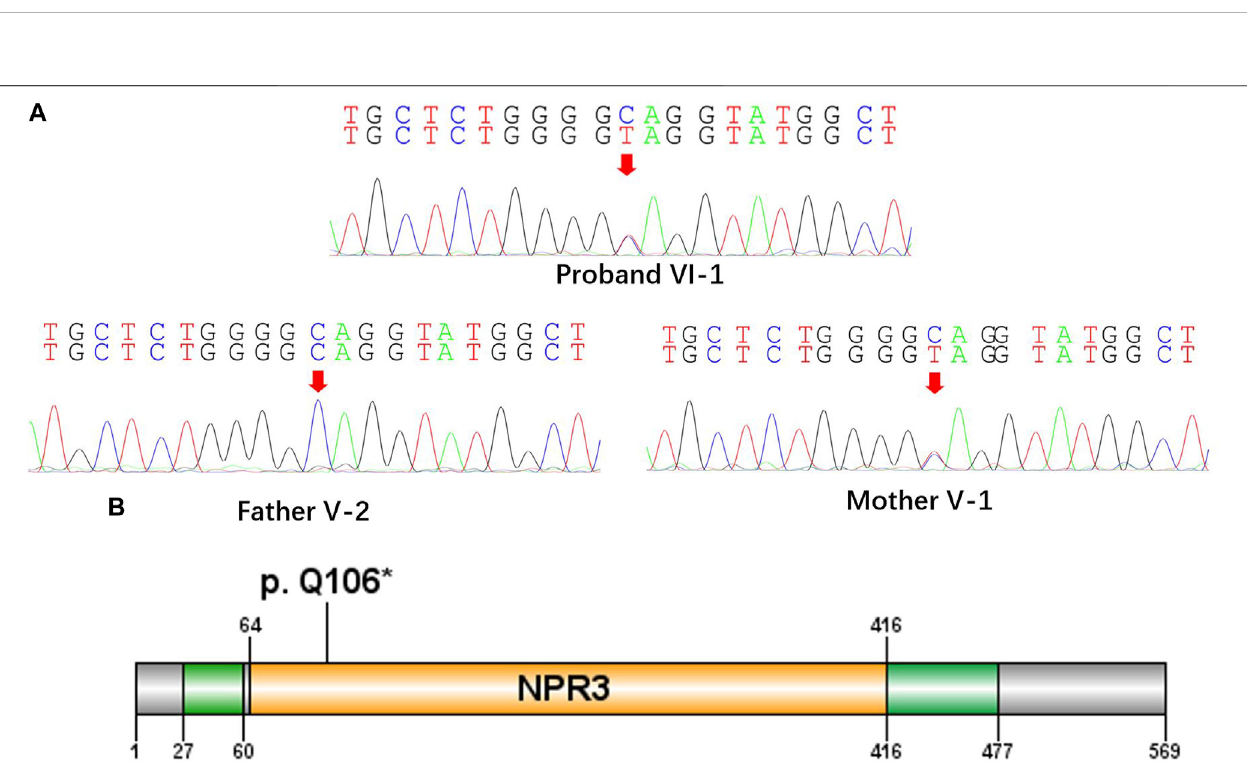
FIGURE 2 | A nonsense mutation c.316C > T, p . Gln106* in the NPRL3 gene. (A) Sanger sequencing of the parent-proband trio (patients VI-1, V-1, and V-2). The fi lled symbol indicates the affected individual. (B) Protein schematic of NPRL3.